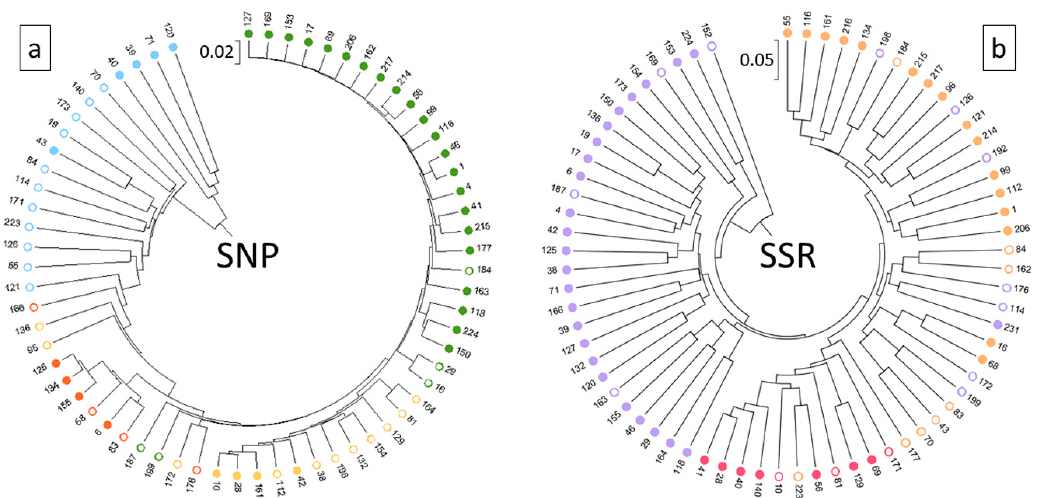
Figure 4. Clustering of the grapevine rootstock core collection (66 genotypes), according to Nei’s distance, defined using 14k SNP ( a ) and 17 SSR ( b ) molecular markers. White filled dots are admixed genotypes. Colors are according to ancestral groups reported in Figure 2.